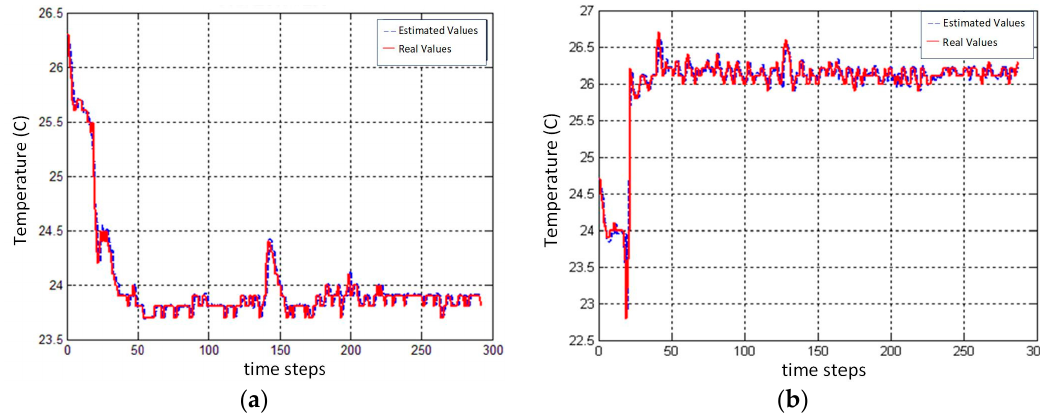
Figure 4. Comparison of air handling unit (AHU) power consumptions between estimated and real values for ( a ) AHU 1; ( b ) AHU 2.